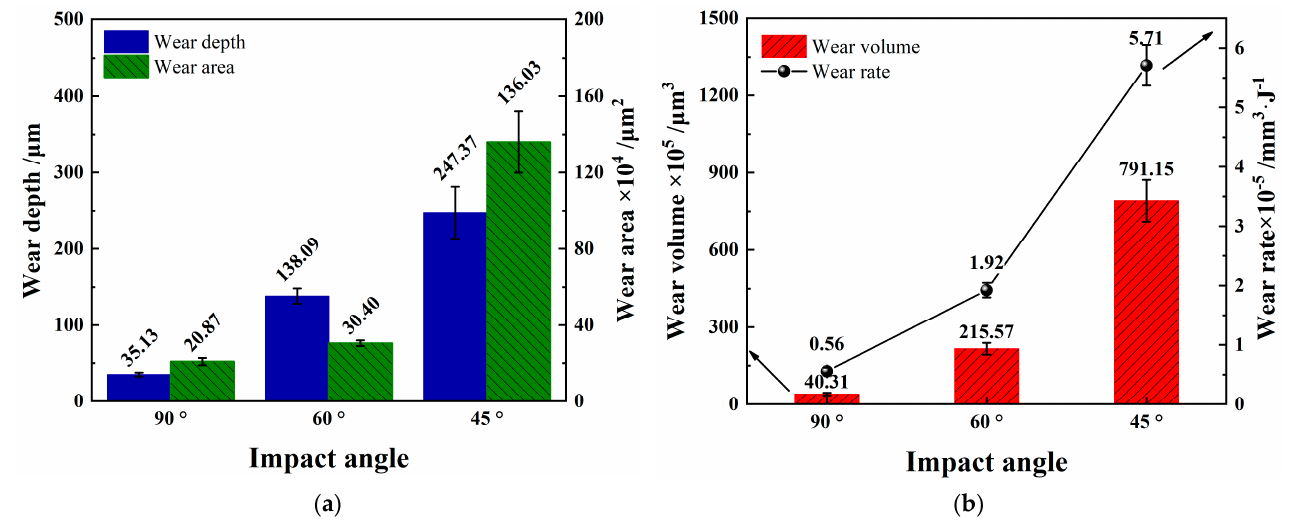
Figure 11. Wear statistics of the worn under varying impact angles. ( a ) Wear depth and wear area; ( b ) wear volume and wear rate.